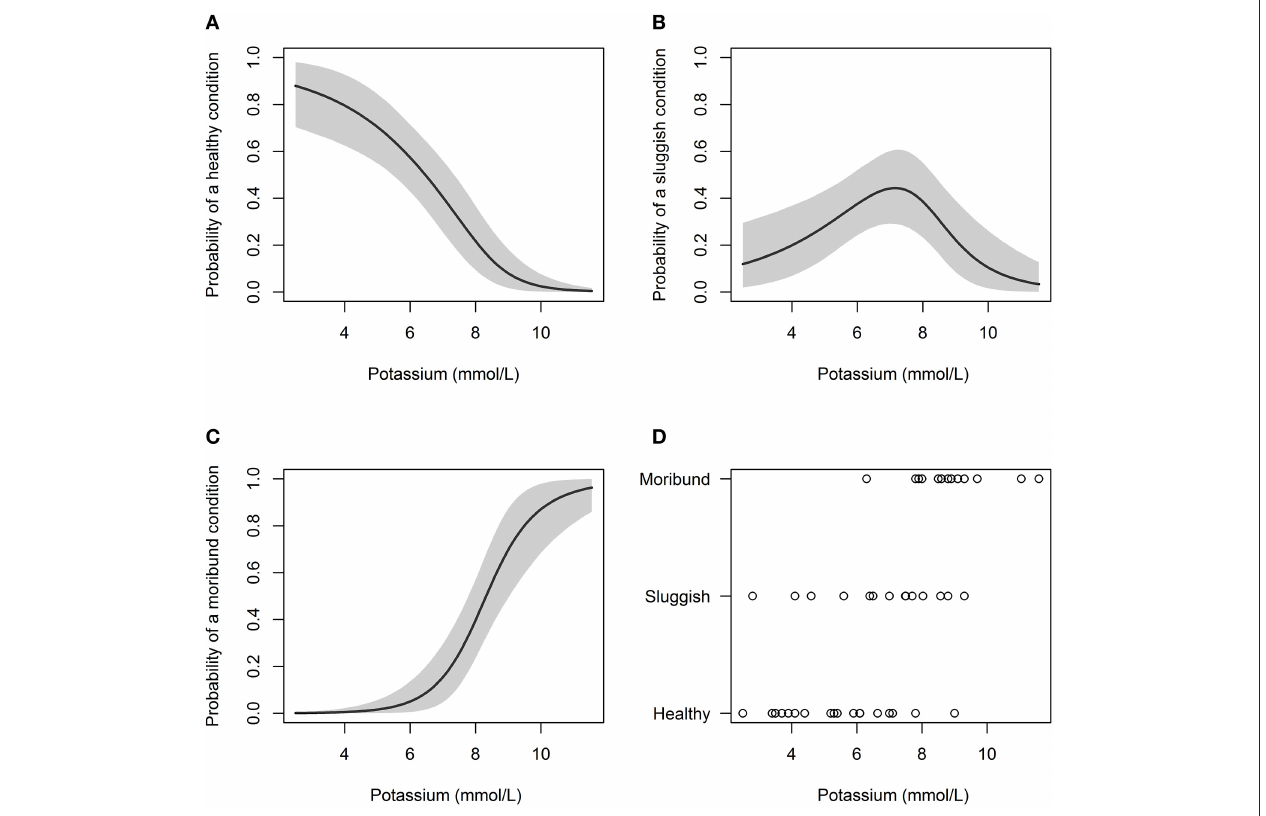
FIGURE 3 | Probability of a C. brachyurus being boated in a certain condition (A – “healthy,” B – “sluggish,” C – “moribund or dead”) given a plasma potassium concentration. Gray shading in (A–C) represents 95% credibility intervals. (D) Plots the raw data vs. potassium concentration, sorted by category (“healthy,” “sluggish,” “moribund or dead”). The mean plasma potassium concentrations for captured sharks in “healthy,” “sluggish,” and “moribund or dead” conditions were 5.4, 6.7, and 8.9mmol/L, respectively.